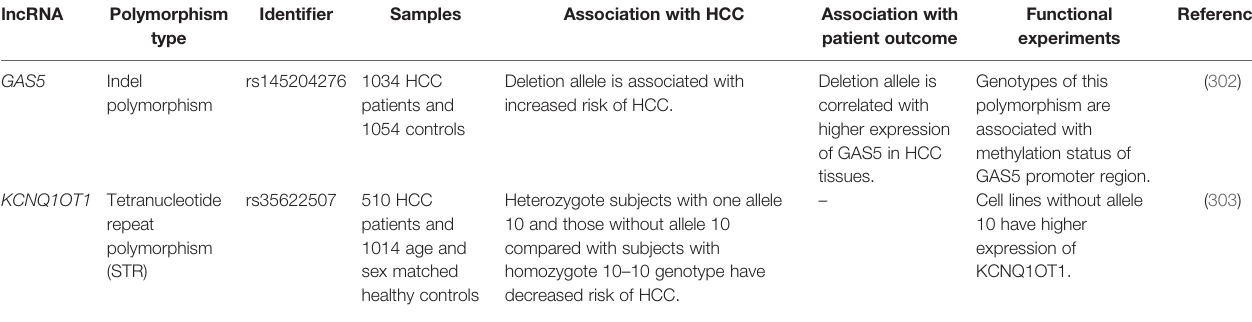
TABLE 5 | Association between lncRNAs polymorphisms and